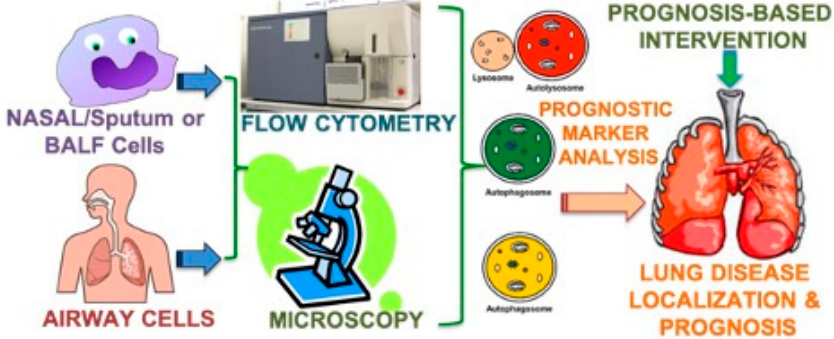
Figure 1. Schematic showing prognostic marker analysis for personalized cystic fibrosis (CF) lung disease intervention. CF transmembrane conductance regulator (CFTR) and prognostic marker(s); membrane, cytosolic or aggresomal expression and localization in induced-sputum/nasal or BALF/airway cell samples using high throughput flow cytometry and/or microscopy based computational analysis for prognosis-based targeted therapeutic intervention.